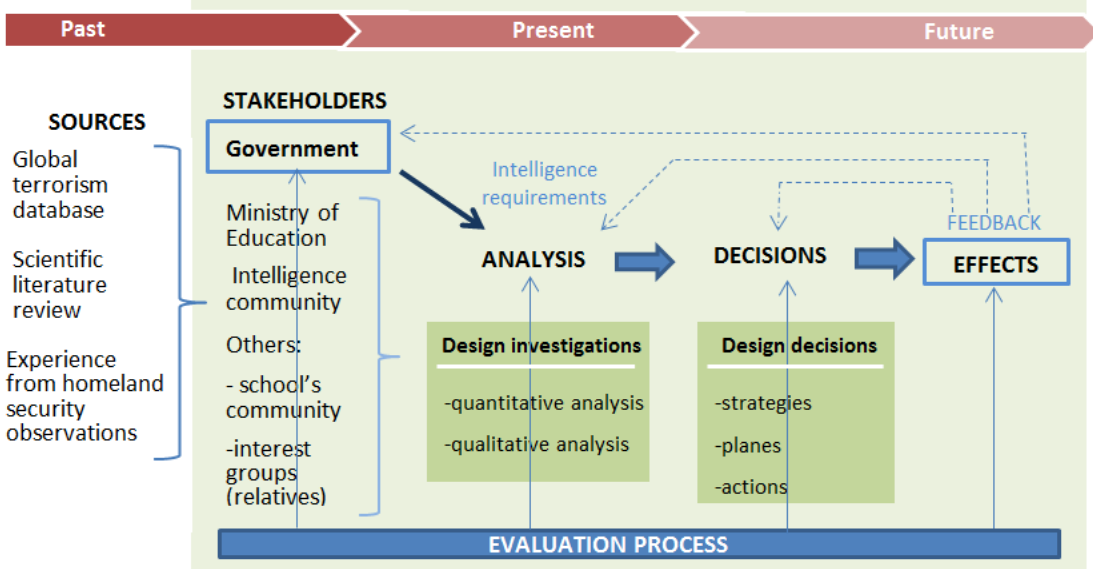
Figure 1. The all-inclusive process of decision-making against terrorist attacks at schools and school facilities. Source: authors.